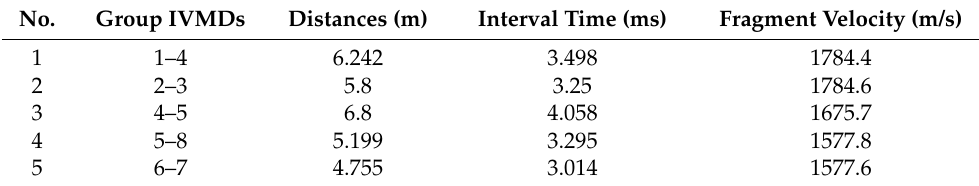
Table 2. The distance between group IVMDs and corresponding interval times.